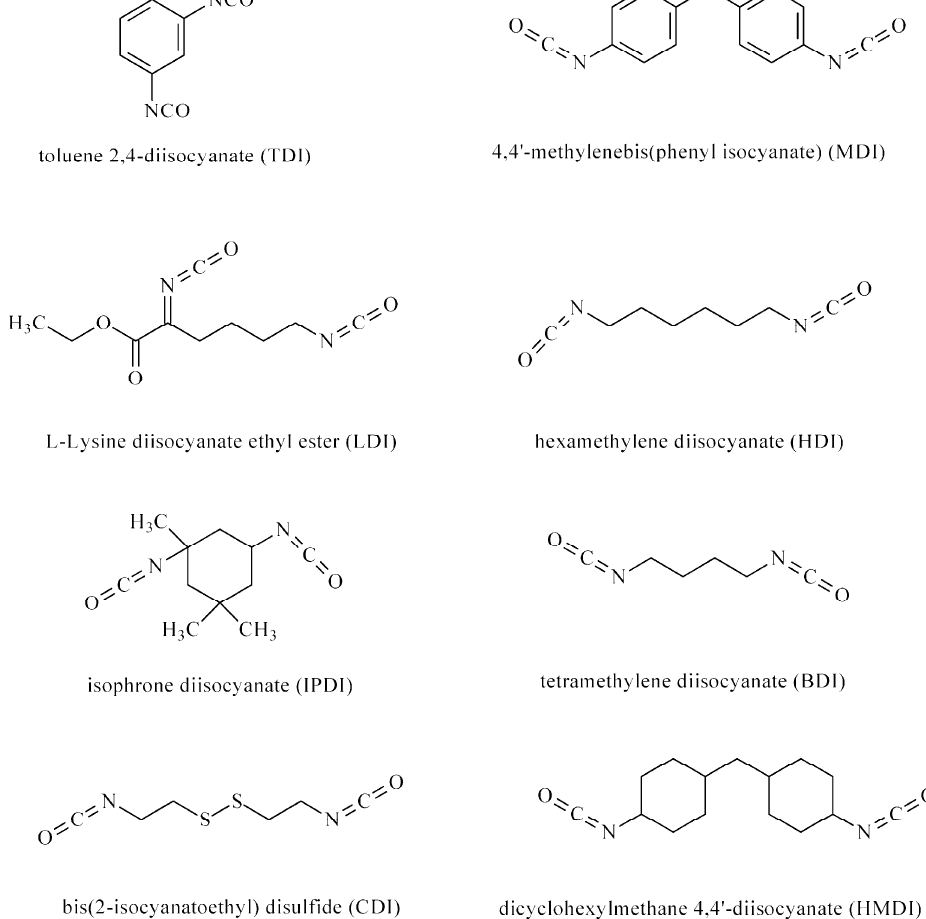
Figure 2. Diisocyanates used for the synthesis of biomedical polyurethanes.